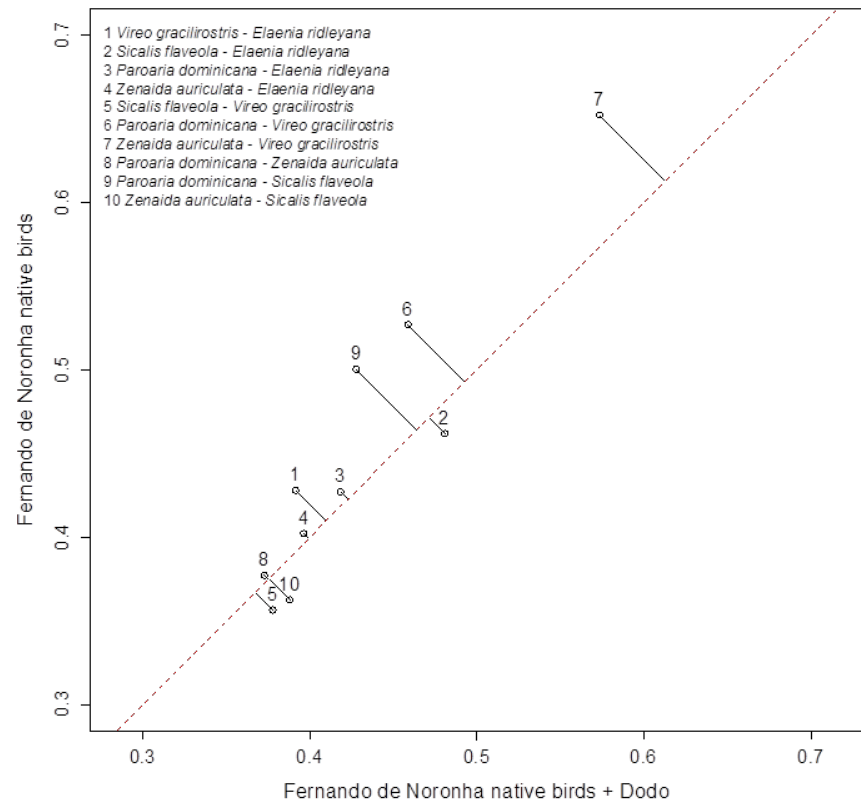
Figure 1. Relationship between functional distances among native bird species from Fernando de Noronha (03° 51’ S and 32° 25’W) included in Sobral et al. (2016) calculated with and without the inclusion of the iconic extinct Dodo ( Raphus cucullatus ), a flightless species from Mauritius island (20° 17' S and 57 ° 33' E, more than 9800 km from Noro- nha). Notice how the inclusion of a single species that does not belong to the regional pool alters all the pairwise dis- tances among species that do coexist. Solid lines represent deviations from the 1:1 relationship (red dashed line). Ac- cording to Villeger et al. (2017) it is not an issue to let a species that never coexisted (nor will do) with the native fauna of a given region to alter the ecological distances among these species. Defining an ecologically relevant distance is a matter for debate, but a good starting point would be to present a logical framework that justifies the inclusion of all possible species in a given functional space without any biological criteria in order to build the “correct” functional space. A potential issue with this is to conclude that all functional spaces ever built (and to be built) are wrong, be- cause – by definition – it is impossible to include all species (no matter scale or taxonomic group one